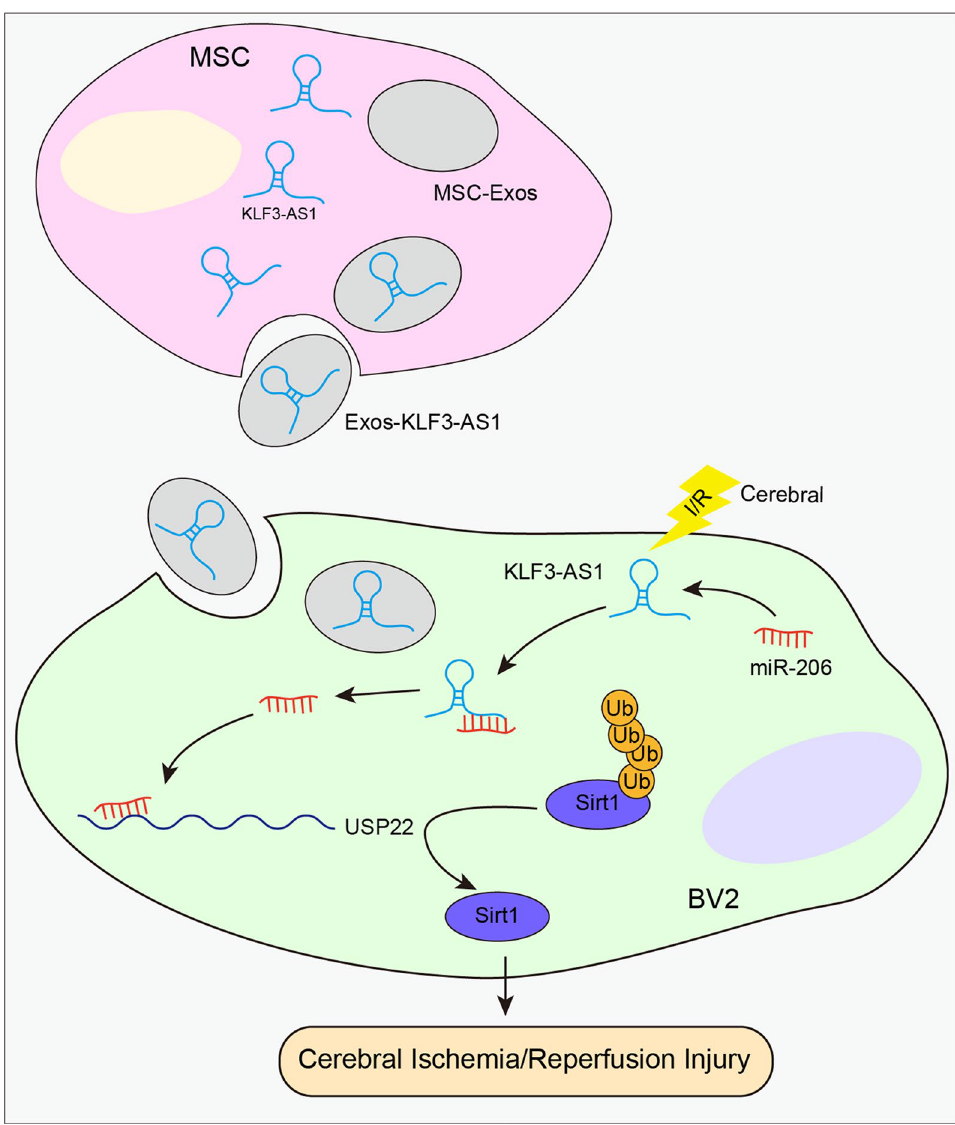
Fig. 7 A schematic graph for drawing the role of KLF3-AS1 in cerebral I/R